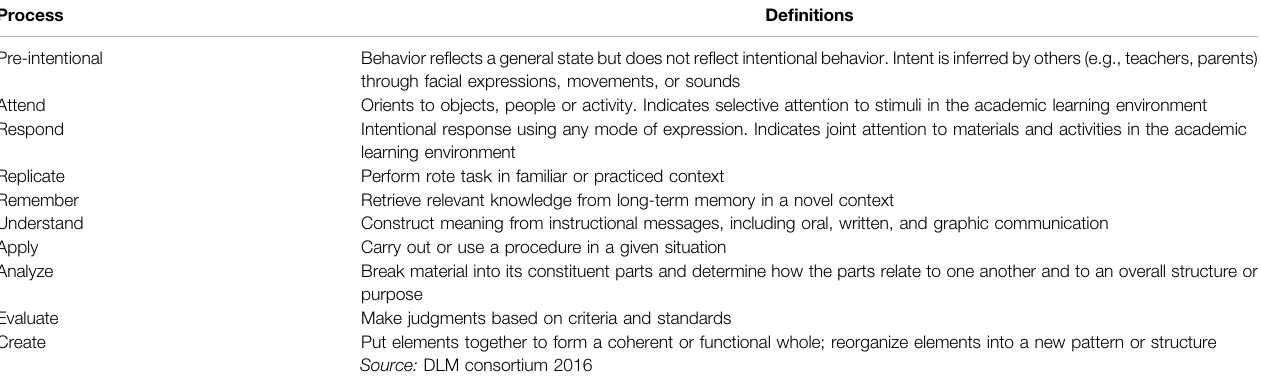
TABLE 2 | DLM ’ s cognitive process dimensions.